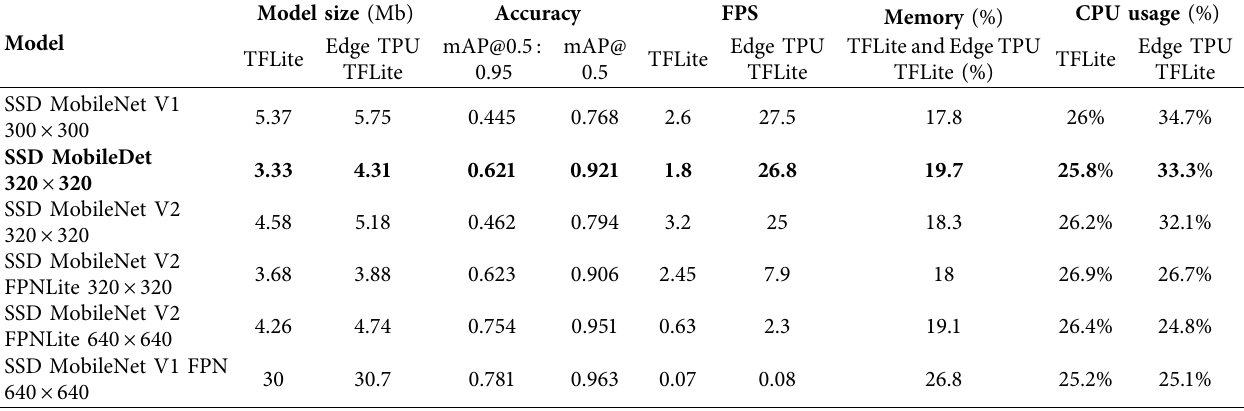
Table 1: Experimental results about running models on Coral Dev